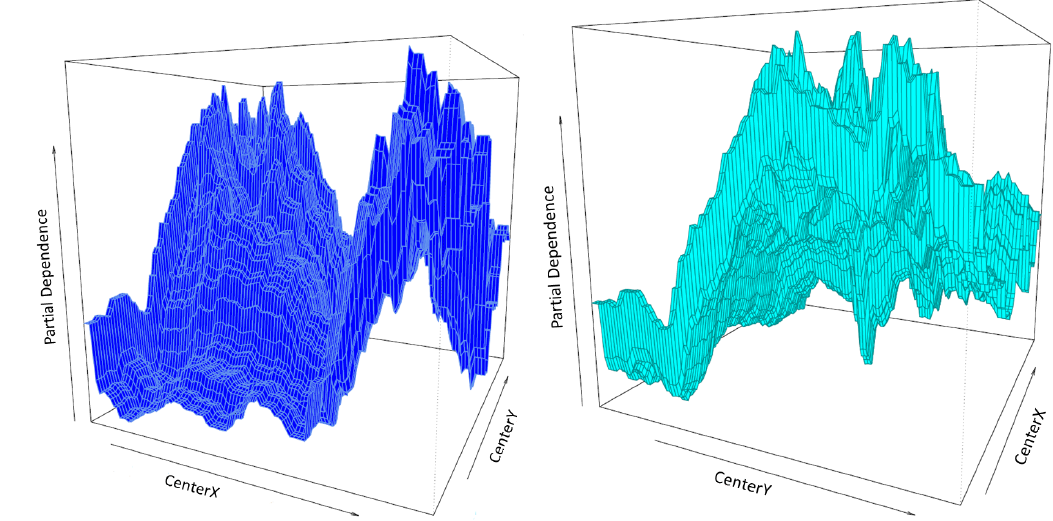
Figure 14. Prediction surface of 1990 in the resolution of 3000 m.